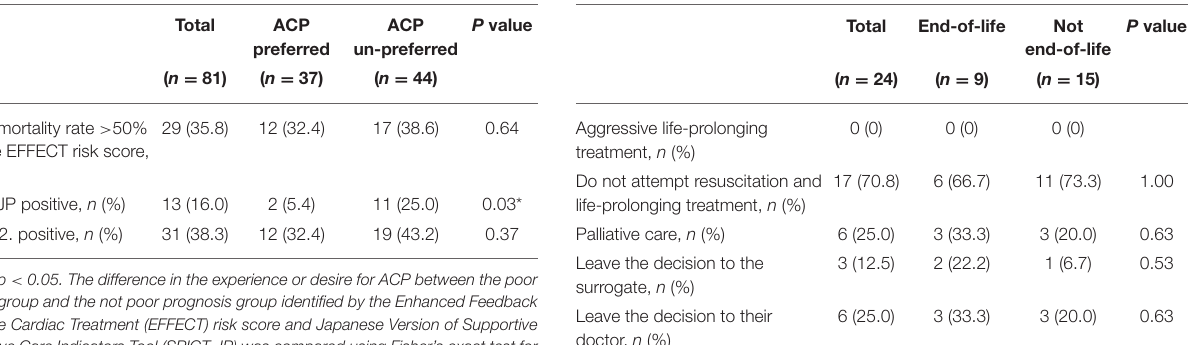
TABLE 4 | Relationship between estimated prognosis and advance care planning (ACP) preference.